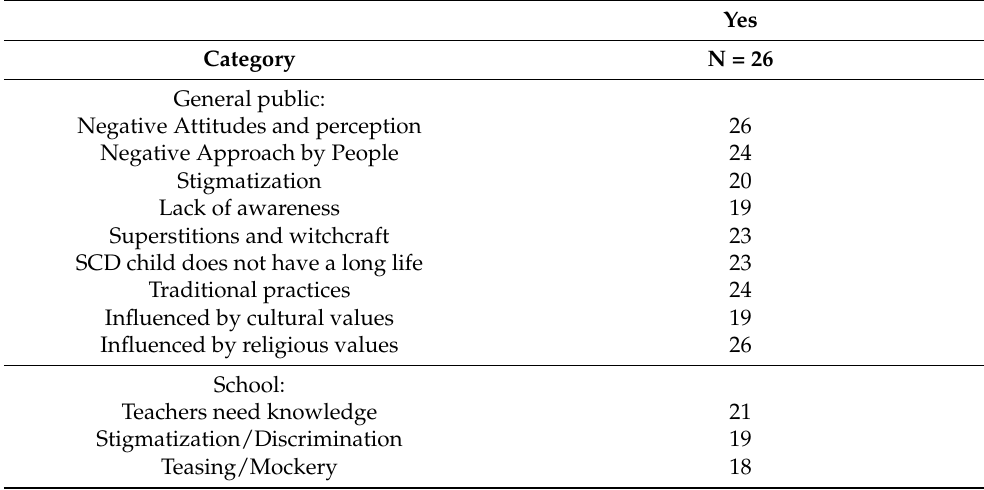
Table 2. The proportion of different responses to attitudes toward and perception of SCD as perceived by the general public and the school as reported by parents in Kinshasa,